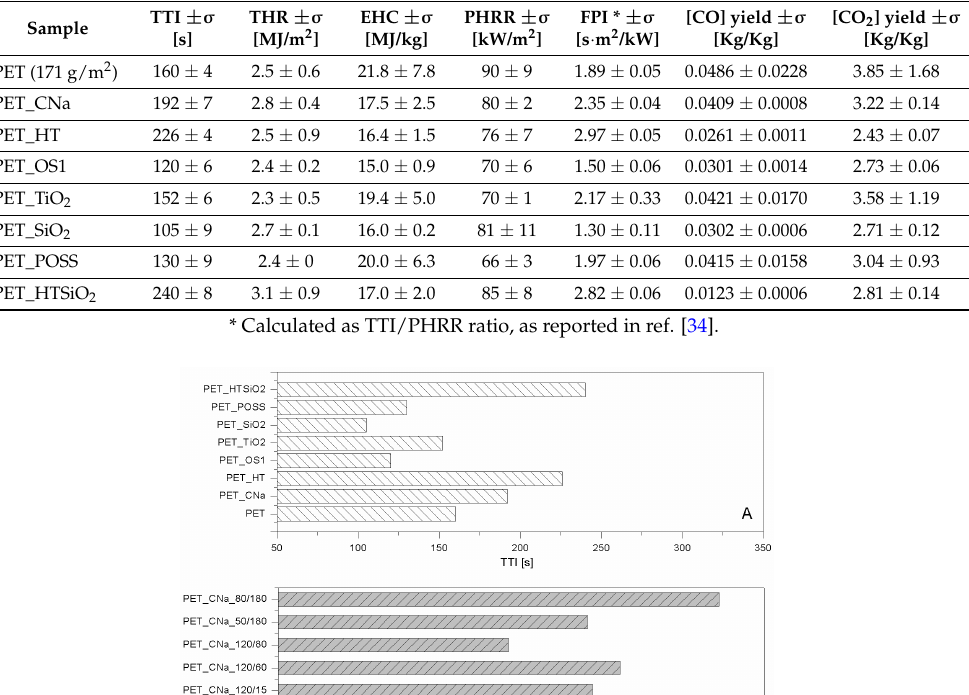
Table 1. Combustion data of untreated and nanoparticle (NP)-treated polyethylene terephthalate (PET) by cone calorimetry (35 kW/m 2 ) [22,32,33].